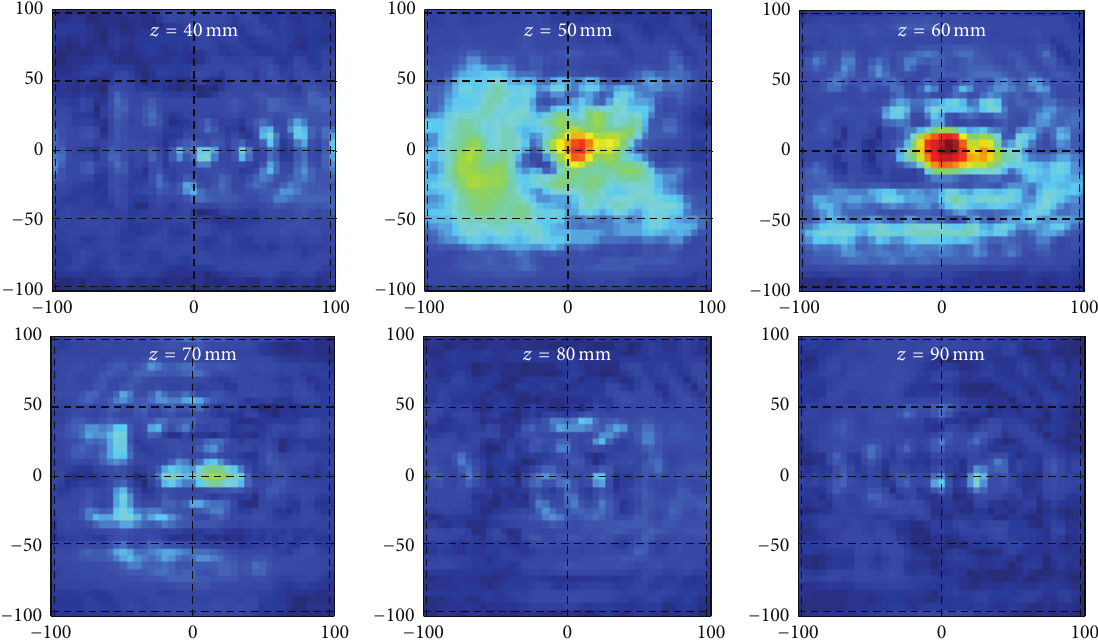
Figure 13: Reconstructed images (shown every 10mm along the 𝑧 axis) when the distance between the reconstruction planes is Δ𝑧 = 5mm using the data in the frequency range from 3GHz to 20 GHz in the experimental example. Color bars are the same as those in Figure 5. The horizontal and vertical axes show the positions along the 𝑥 and 𝑦 directions in terms of